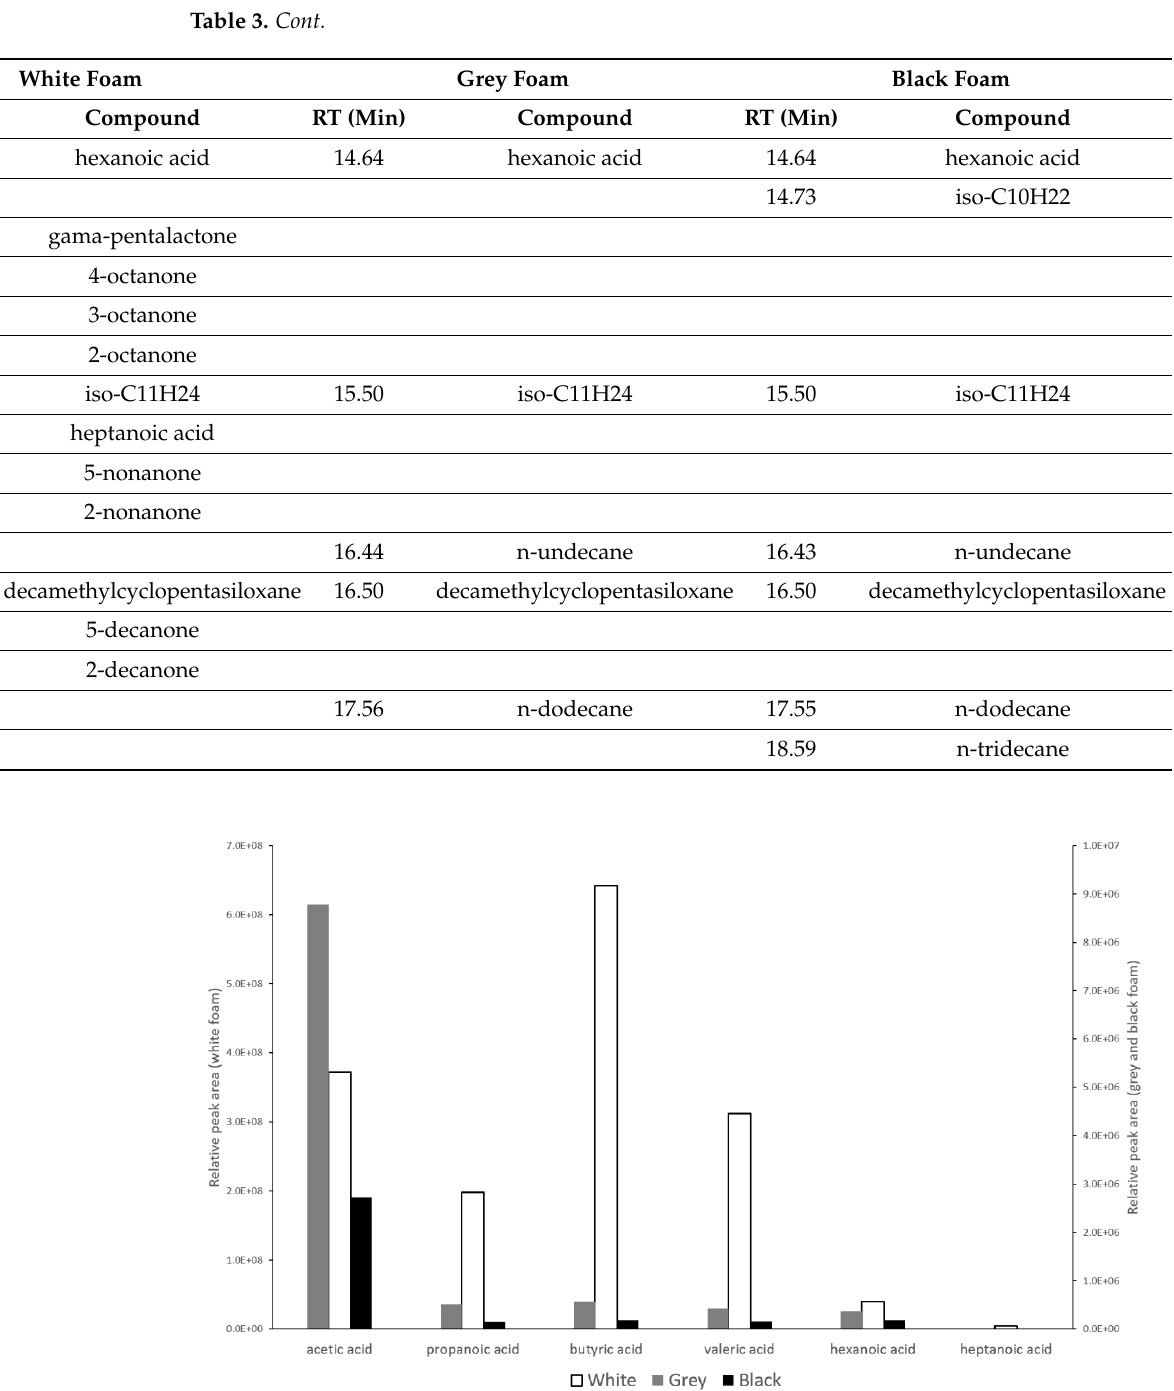
Figure 7. Relative ratios of the peak areas for organic acids detected by